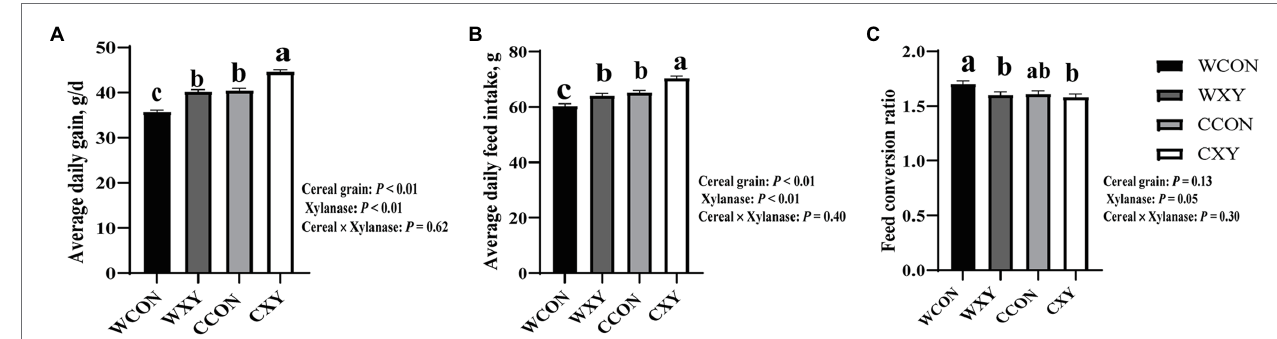
FIGURE 1 | Growth performance of broilers fed corn- or wheat-based diets with or without xylanase during 6-week period. Dietary treatments consisted of wheat- soybean basal diet (WCON), wheat-soybean basal diet with 4,000 U/kg xylanase (WXY), corn-soybean basal diet (CCON), and corn-soybean basal diet with 4,000 U/kg xylanase (CXY). (A) Average daily gain. (B) Average daily feed intake. (C) Feed conversion ratio. Significant differences ( p < 0.05) among different groups are indicated by different letters. Values are expressed as means ±